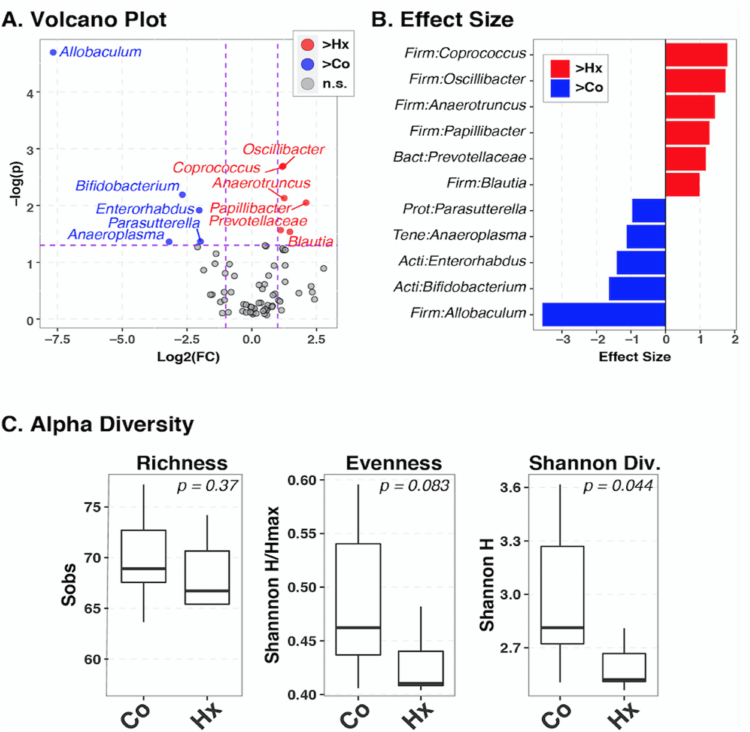
Figure A1. Identification of bacterial taxa differing between hypoxia and control groups. Between- group differences in the relative abundance of individual bacterial taxa were identified using the ANOVA-like differential expression (ALDEx2) test, which takes into account the compositional nature of microbiota datasets. Taxa with fold-changes >2 and nominal p -values <0.05 (Welch test) are considered significant; ( A ): plot of log2(fold-change) vs. − log10( p -values). Taxa in the upper right quadrant, colored red, were significantly enriched in the hypoxia group (Hx) compared to controls (Co). Conversely, taxa in the upper left quadrant, colored blue, were significantly enriched in the control group compared to hypoxia. Gray circles in bottom quadrant were not significant (n.s.). Vertical and horizontal dashed lines indicate the fold-change and p -value cutoffs; ( B ): Relative effect sizes are plotted for significant taxa. Values >0 (red colors) indicate taxa that were elevated in relative abundance in the hypoxia group compared to controls. Values <0 (blue colors) indicate taxa that were enriched in the control group compared to hypoxia; ( C ): Alpha-diversity differs between hypoxia and control groups. Boxplots summarize distributions of three measures of alpha-diversity between the Co and Hx groups. p -values were ascertained by Student’s t-test with the Welch approximation. Sobs: Species observed (number of taxa observed in each sample). Hmax: maximum value of the Shannon Diversity index for each